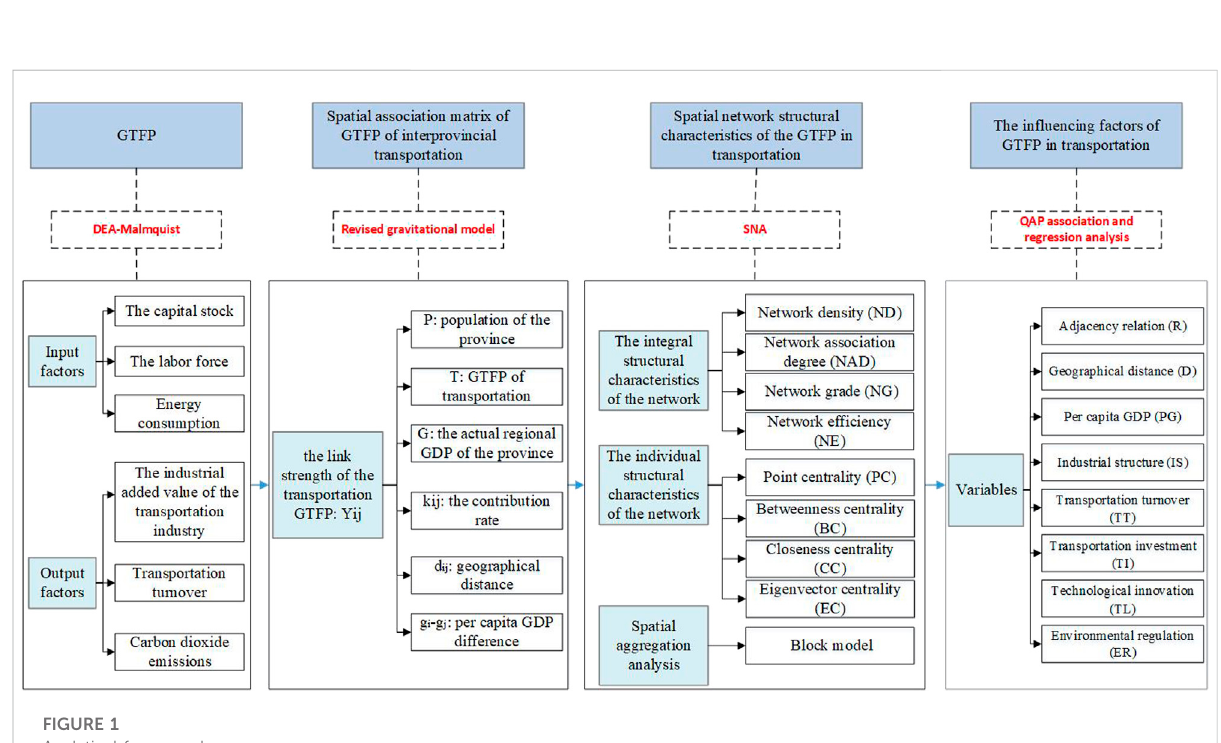
FIGURE 1 Analytical